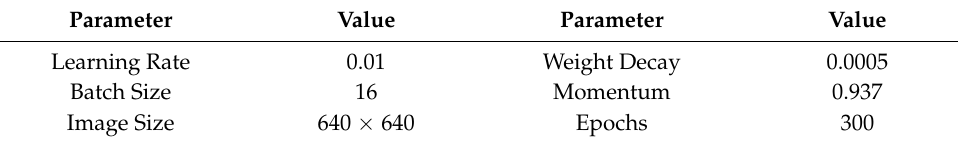
Table 1. Training